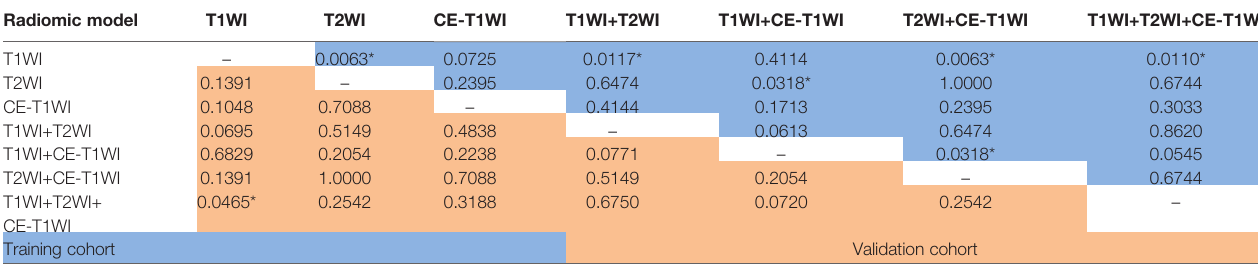
TABLE 8 | Delong Test between each two models of LR-classi fi er in the training and validation cohorts. Radiomic model